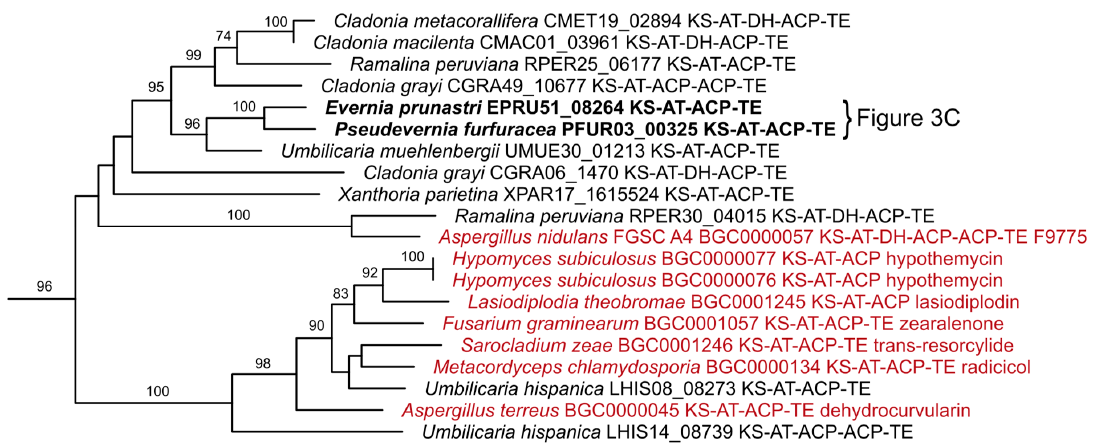
Figure 9. Supported clade containing the PKS orsA for orsellinic acid in Aspergillus nidulans (MIBiG-ID BGC0000057). For the complete KS tree see Figure S1.